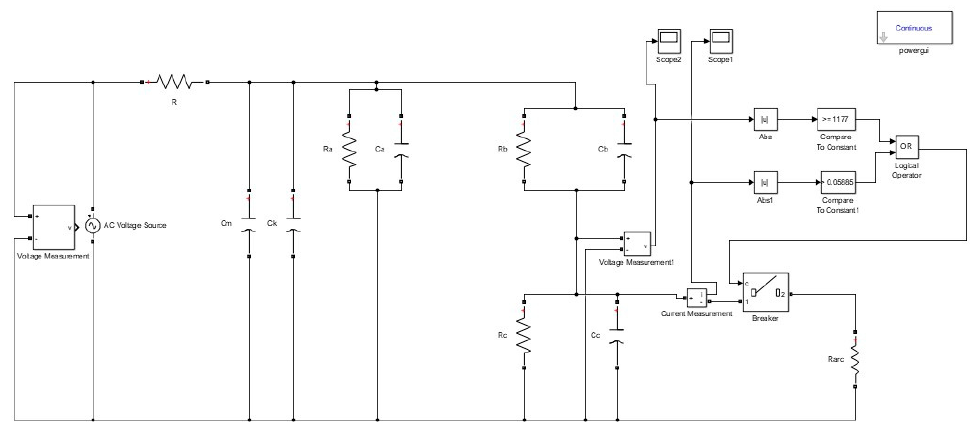
Figure 22. Advanced capacitive resistance PD model.